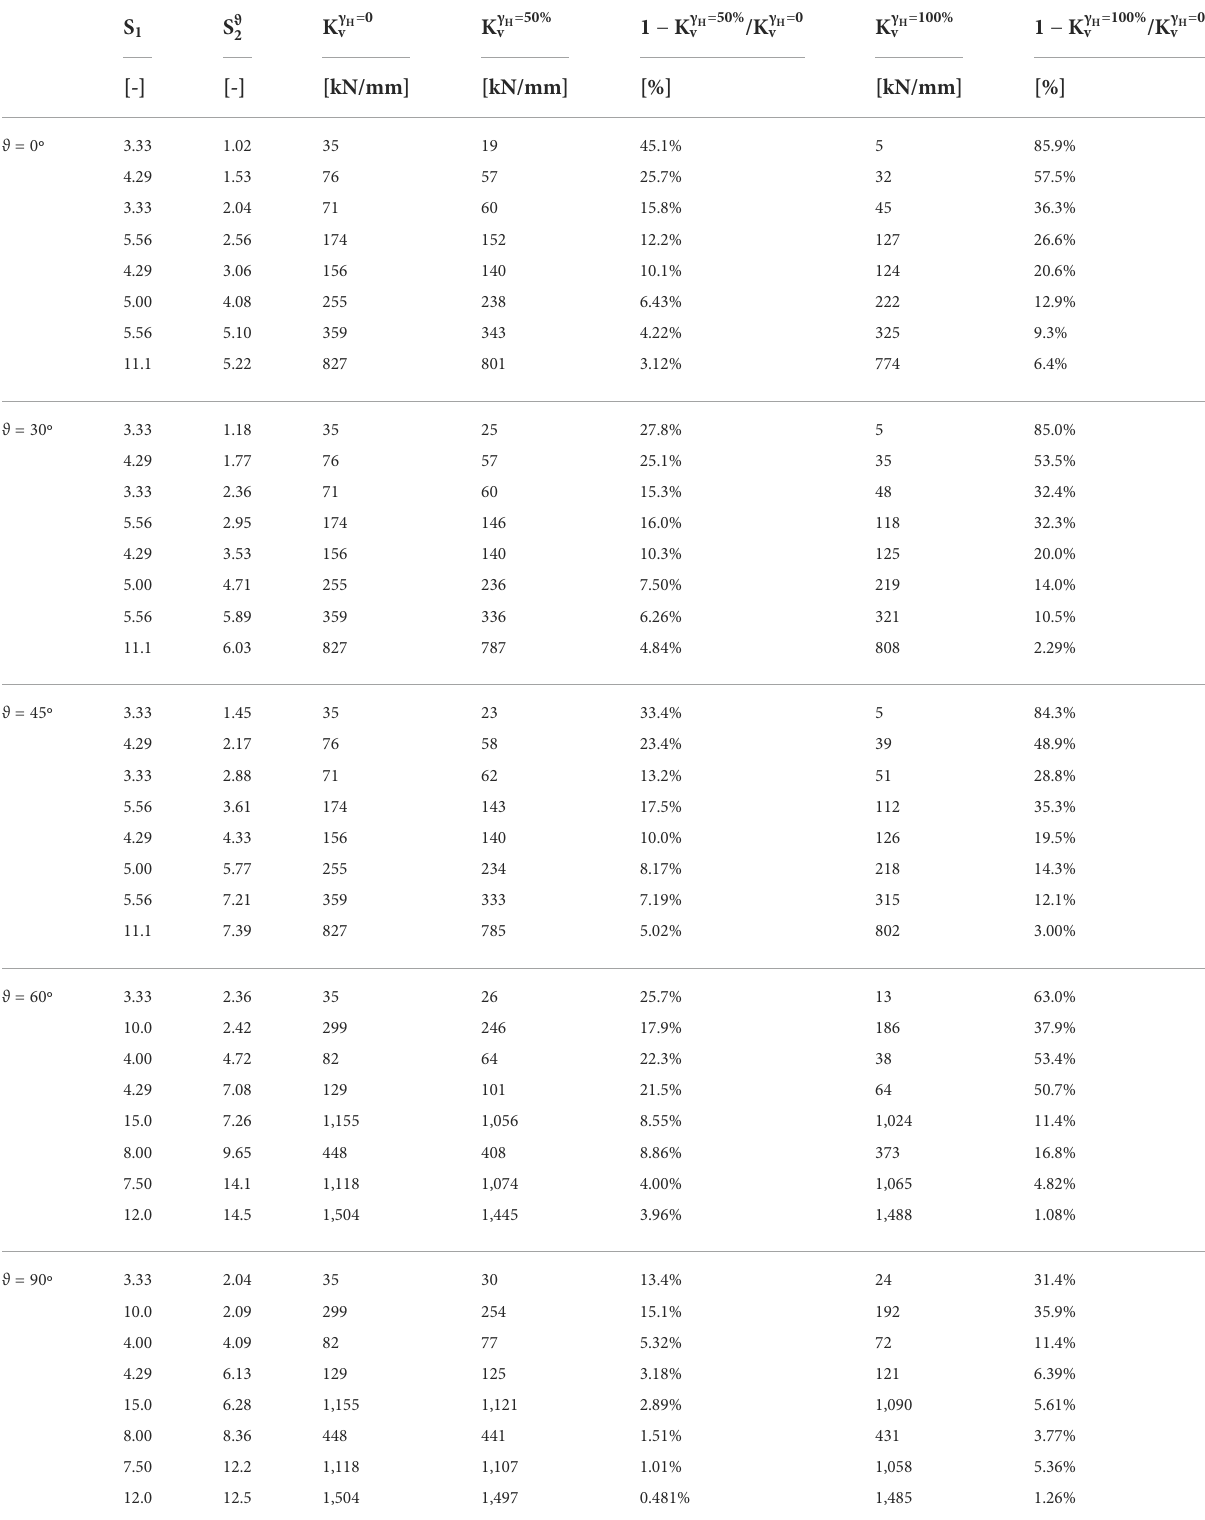
TABLE 4 Percentage reductions of the vertical stiffness with the shear strain in the different horizontal loading directions for bearings with variable secondary shape factors. S